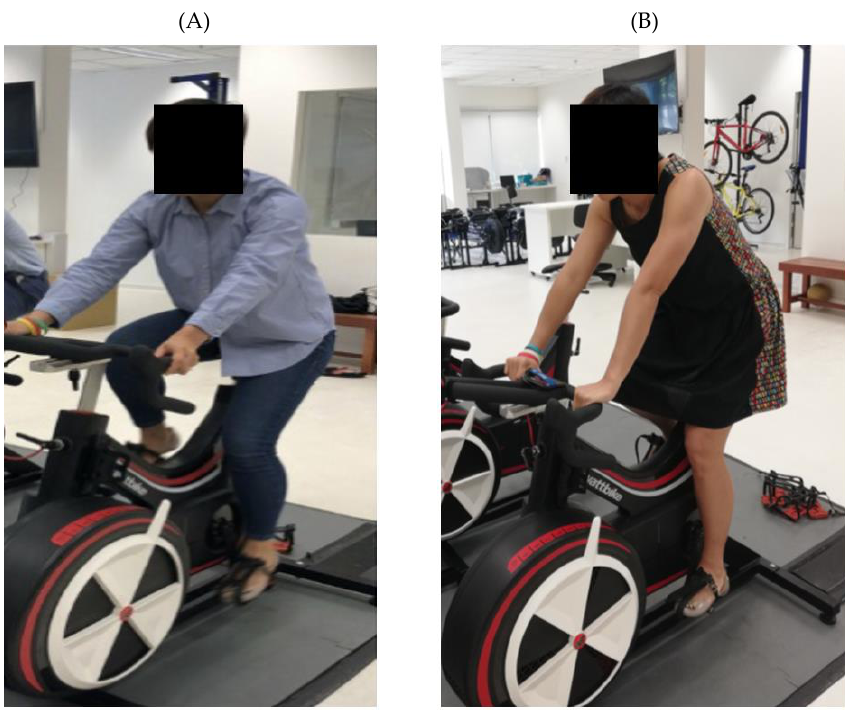
Figure 1. Participating individuals performing the dispersed protocol of the 30 s Wingate Anaerobic cycle Test (WAnT) bouts in two of the most common non-sporting attires; in ( A ) jeans with shirt or t- shirt, and ( B ) long-skirt. Table 2. Frequencies of the rest periods between the morning and afternoon exercise bouts, and between the afternoon and evening exercise